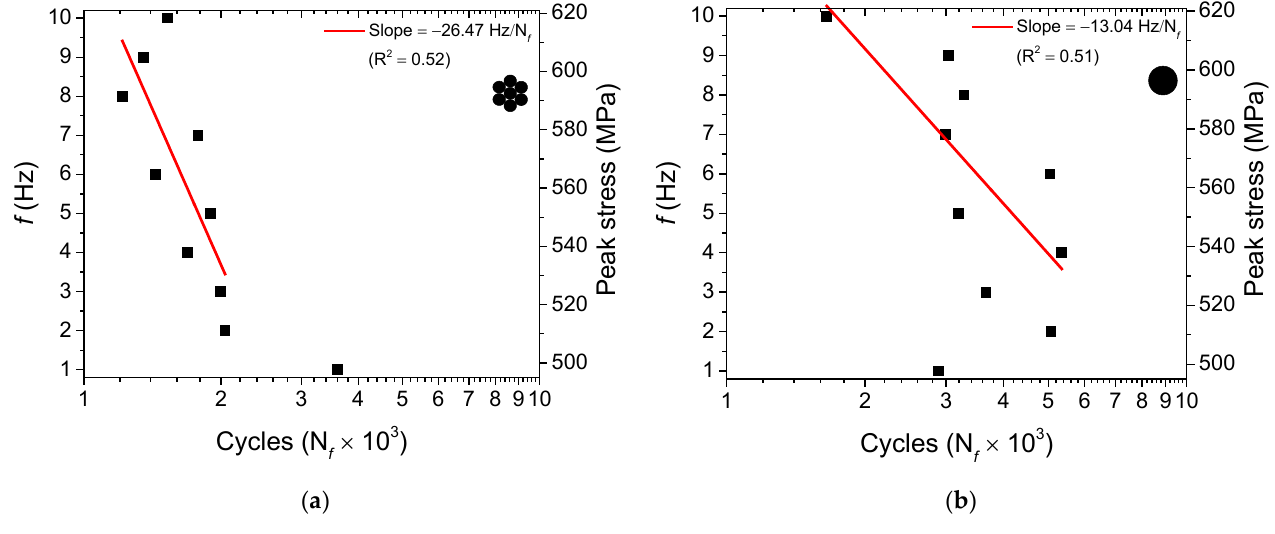
Figure 20. Fatigue life at different loading frequencies between ε min = 2.5% and ε max = 7.5%. ( a ) SMA NiTi micro cable. ( b ) Reference element.